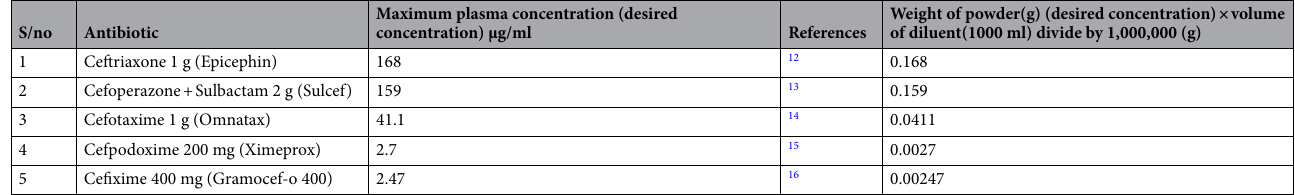
Table 2. Weight of powder for stock